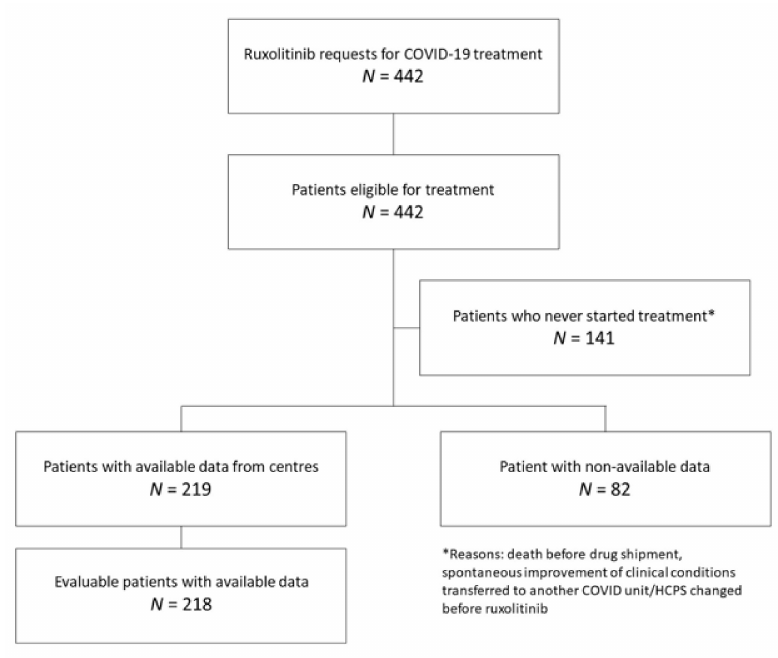
Figure 1. Patient